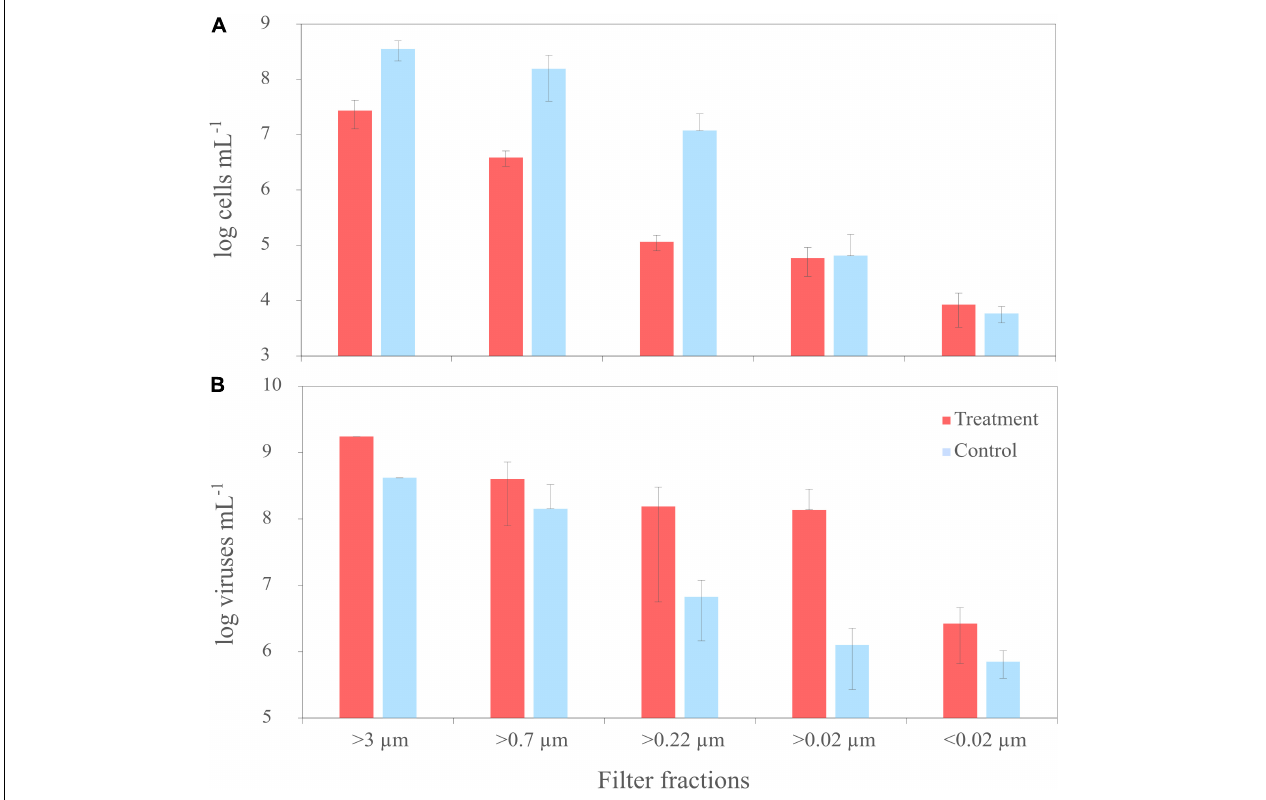
FIGURE 2 | Trends of cell numbers (A) and virus abundances (B) of the mitomycin C treated (‘treatment’) and untreated cultures (‘untreated’) of R. sulfidophilum during sequential filtration through filters with various pore sizes. Biological replicates are averaged ( n = 3) and standard deviations are indicated by the error bars. Virus counts from two treatments and untreated controls of the filter fraction > 3 µ m were not measured due to loss of samples during